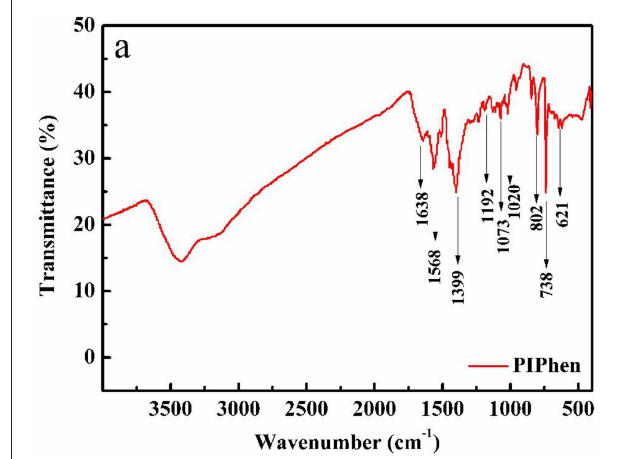
FIGURE 1 | Infrared spectrum of